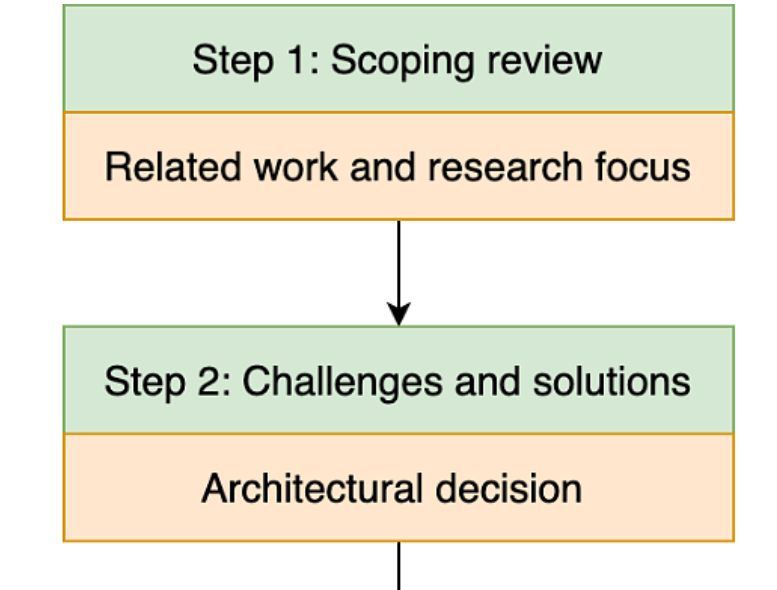
Figure 1. Research design process flow: 4-step